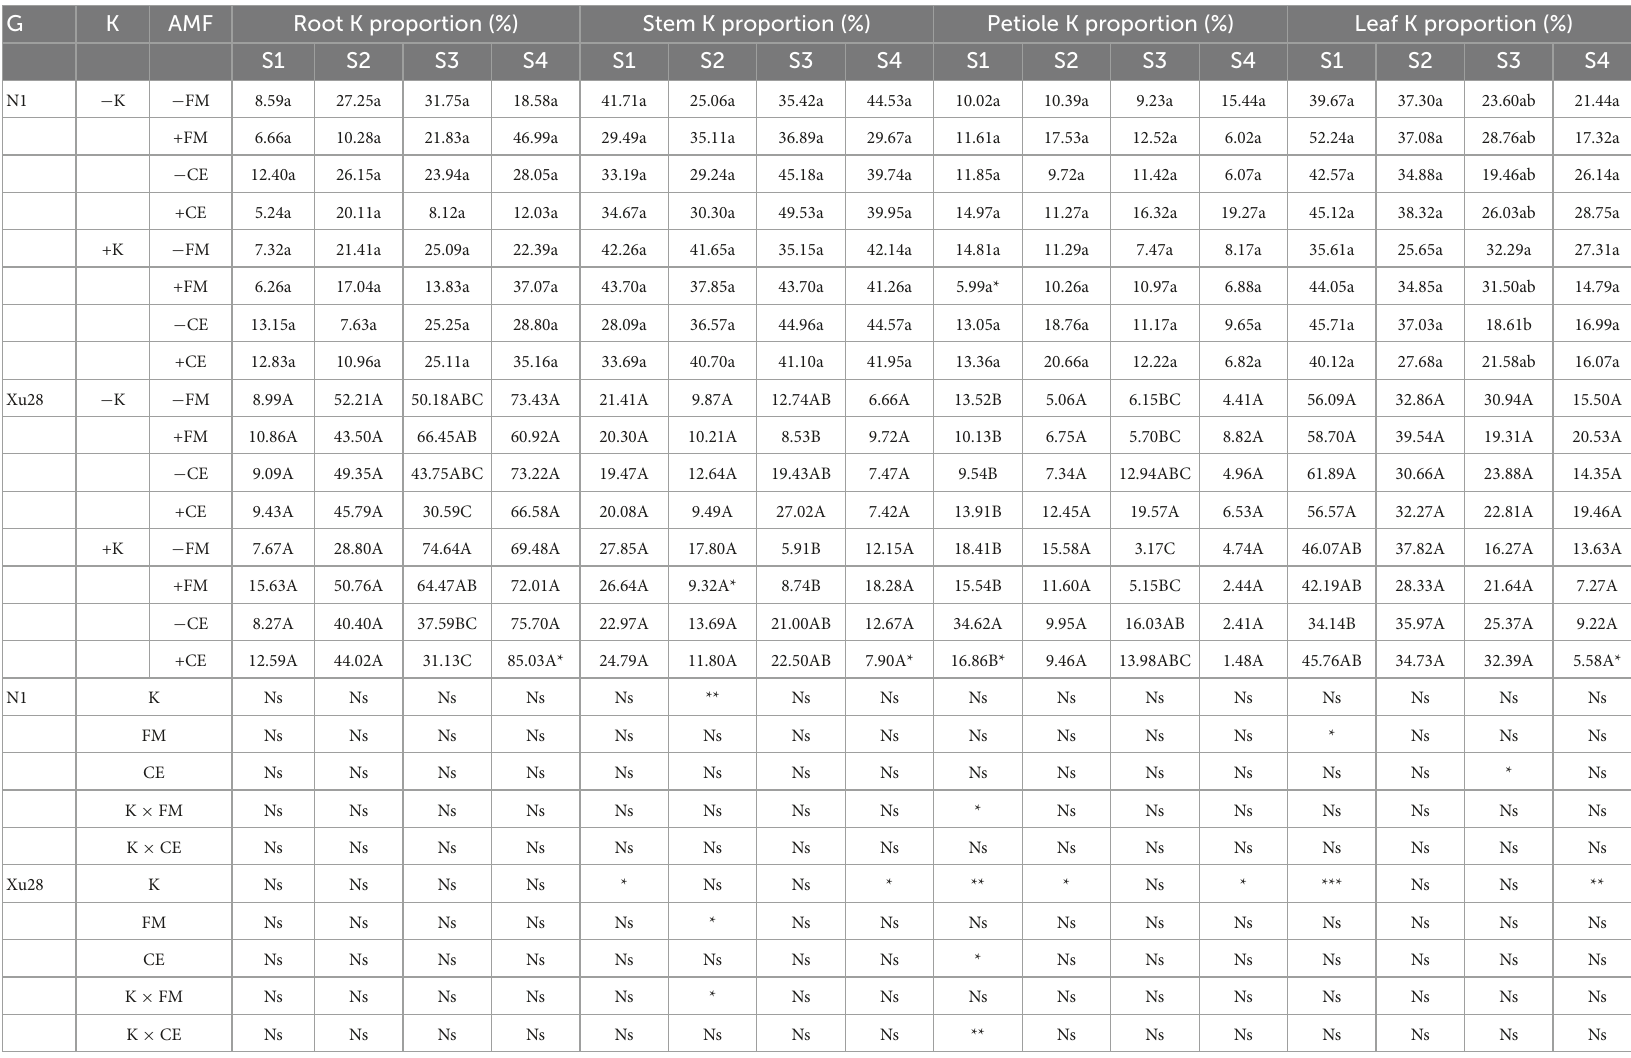
TABLE 2 The effects of K application and arbuscular mycorrhizal fungi (AMF) inoculation on the proportion of K accumulation in different organs of sweet potato.